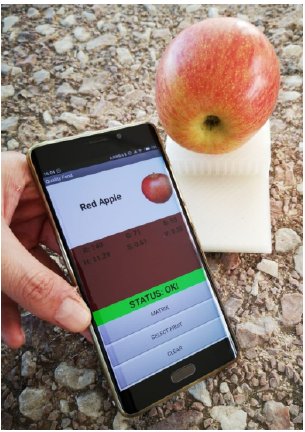
Figure 20. Measurement of a red apple using the designed application.